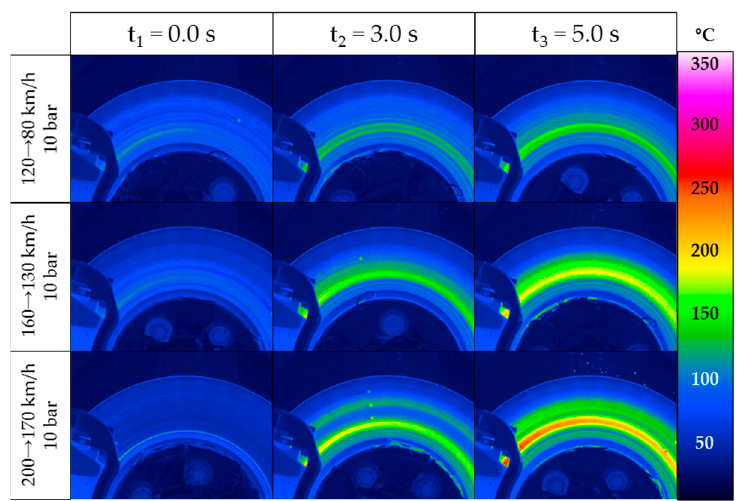
Figure 1. Temperature distribution over the disc surface—Speed variation at 10 bar [24].